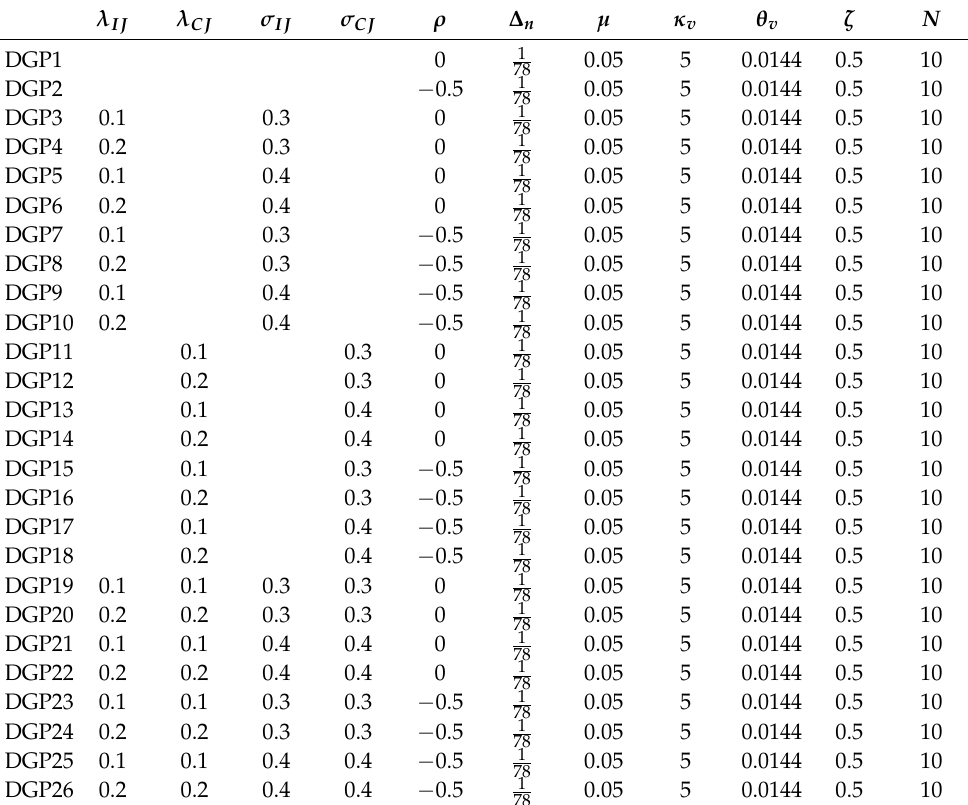
Table 2. Monte Carlo experiments—data generating process